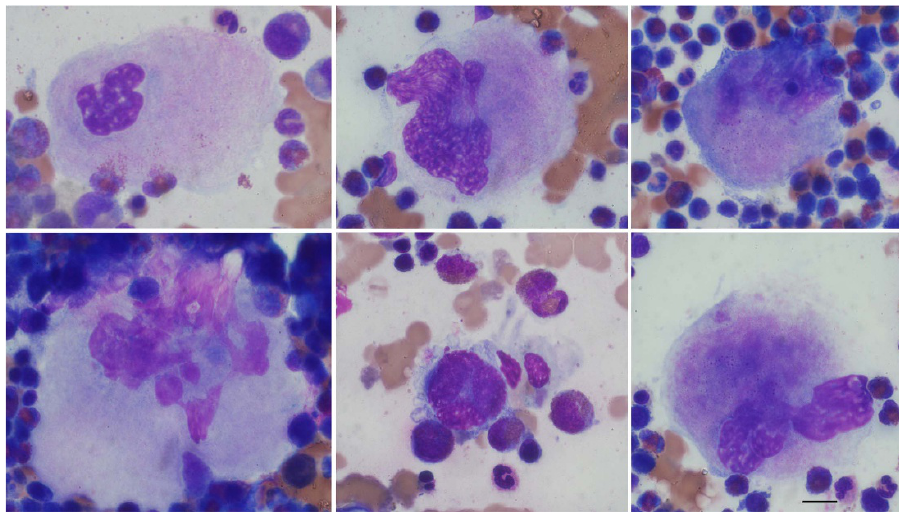
Figure 8 | Bone marrow megakaryocyte morphology from Patient 1. Diagnostic bone marrow aspirate showing normal megakaryocytes with multilobed nuclei and large cytoplasm indicating normal morphology. Images were acquired from marrow smear preparations after Wright–Giemsa staining. Magnification (cid:3) 60, bar ¼ 10 m